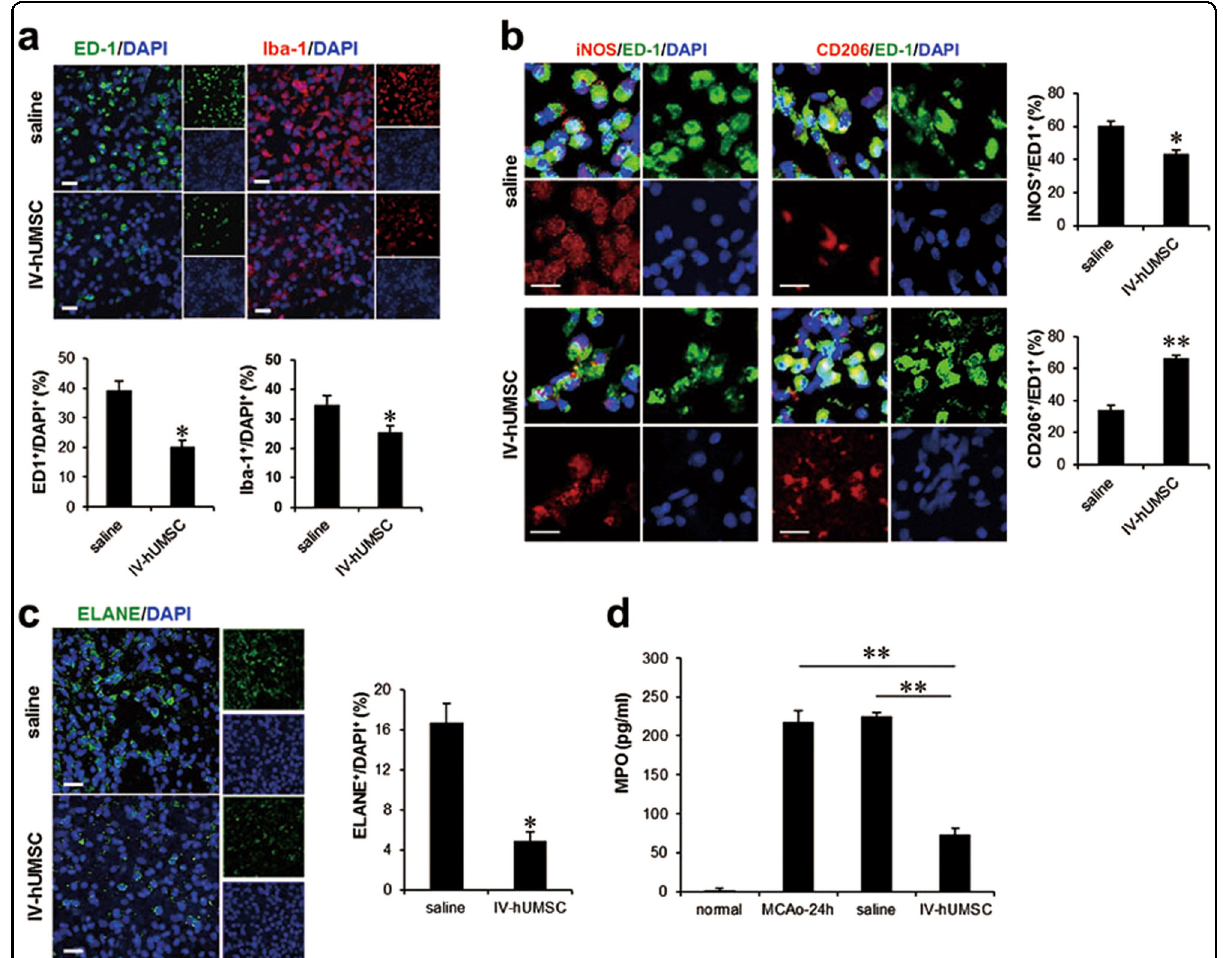
IV-hUMSC group and saline group ( n = 5 per group). b iNOS and CD206 immunostaining of the peri-infarct area between the IV-hUMSC group and saline group ( n = 5 per group). c Immunohistochemistry of neutrophil elastase (ELANE) in the peri-infarct area between the IV-hUMSC group and saline group ( n = 5 per group). d Enzyme-linked immunosorbent assay (ELISA) of myeloperoxidase (MPO) in lysates of the ischemic hemisphere of rats with no MCAo (normal group, n = 5), rats with 24 h post MCAo (MCAo-24 h group, n = 5), rats with 72 h post MCAo treated with saline (saline group, n = 5), or 1 × 10 6 IV-hUMSCs at 24 h post MCAo (IV-hUMSC group, n = 5). All data are presented as the mean ± SEM. * p < 0.05 or ** p <